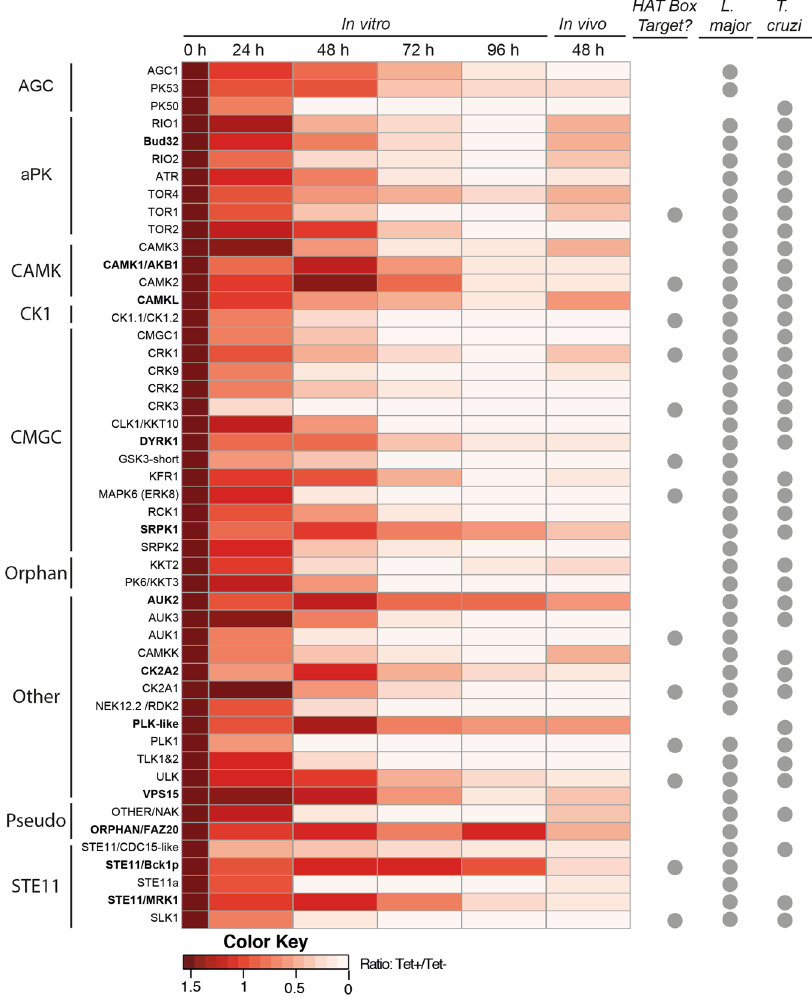
Figure 3. Heatmap depicting 49 cell lines showing loss of fitness during in vivo RNAi and their corresponding in vitro RNAi phenotypes. An individual PK from the library is represented in each row and they are grouped by family; those appearing in bold font were not identified as showing loss of fitness by in vitro Alamar blue screening 6 . The 0 h column is artificially adjusted to a solid colour representing a baseline value, the remaining heatmap columns represent the actual mean RIT-seq value determined at each time point up to 96 h in vitro and the 48 h in vivo time point. Lighter shades represent the reduction in the RIT-seq value and thus the loss of a cell line from the library. HAT Box Target? refers to a protein kinase that is a potential target for compounds in the GSK HAT Box by phylogenetic orthology to a human PK targeted by a compound in the box 8 . The L. major and T. cruzi columns use a circle to denote if an orthologue of the T. brucei gene encoding the protein kinase is present in the respective organism (see Data set